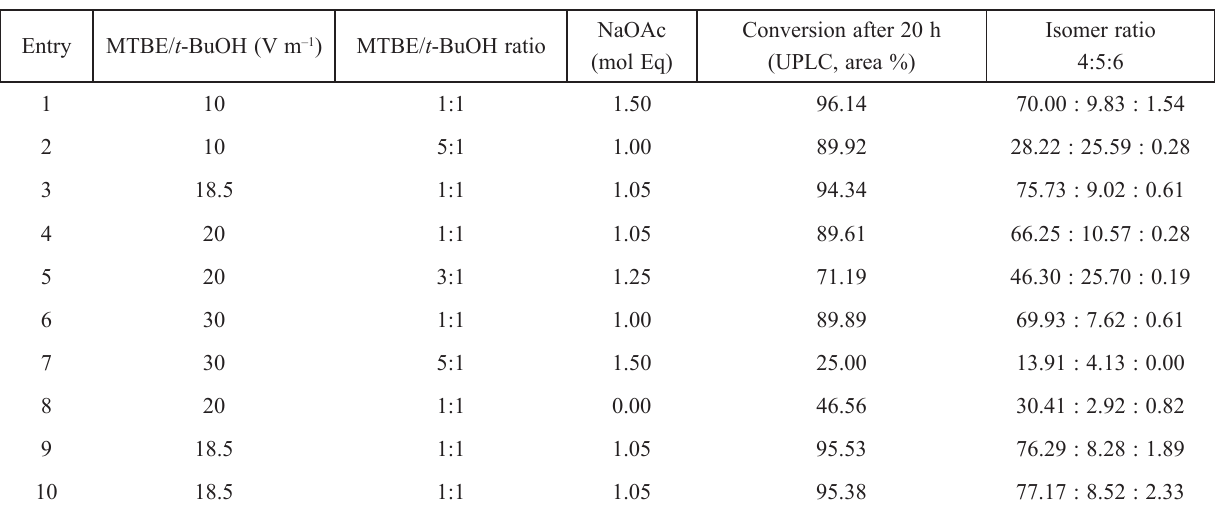
Table 4 – Final DoE with critical 3 parameters (Custom Design with minimal number of experiments)